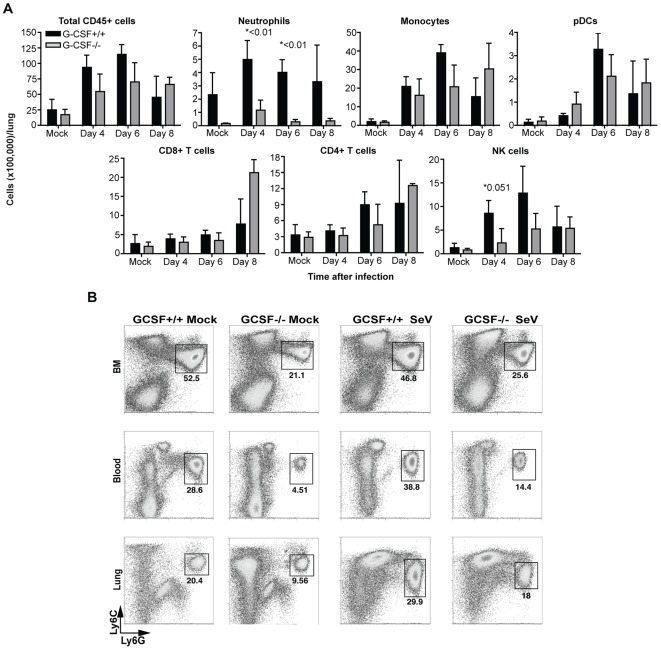
G-CSF regulates the cellular infiltrate during virus infection.(A) Cell numbers in the lungs of SeV infected mice calculated at the indicated time points from total cell counts and flow cytometry analysis. Populations were identified with the following markers: neutrophils (CD11b+Ly6c+Ly6G+), monocytes (CD11b+Ly6C+Ly6G−), pDCs (CD11b−B220+mPDCA+), CD4+ T cells (CD3+CD4+CD8−), CD8+ T cells (CD3+CD8+CD4−), and NK cells (CD11b+NK1.1+). Pre-gated on PI−CD45+ cells. Error bars represent standard deviation from the mean. Asterisks indicate p values (n = 3). (B) Ly6G+ granulocytes in the lung, BM and blood of G-CSF−/− and G-CSF+/+ mice mock treated or infected with SeV for 4 days. Pre-gated on PI−CD45+CD11b+ cells. Results are representative of more than two independent experiments.